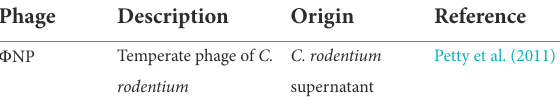
TABLE 2 Bacteriophages used in this